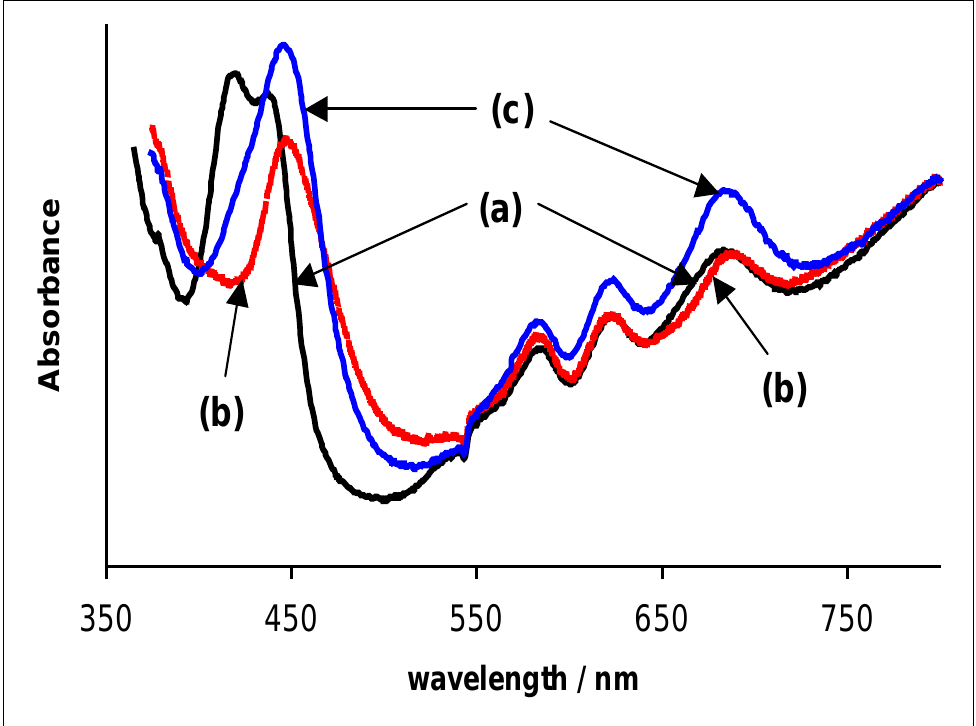
immobilised at a glass slide (a), after 15 s 4